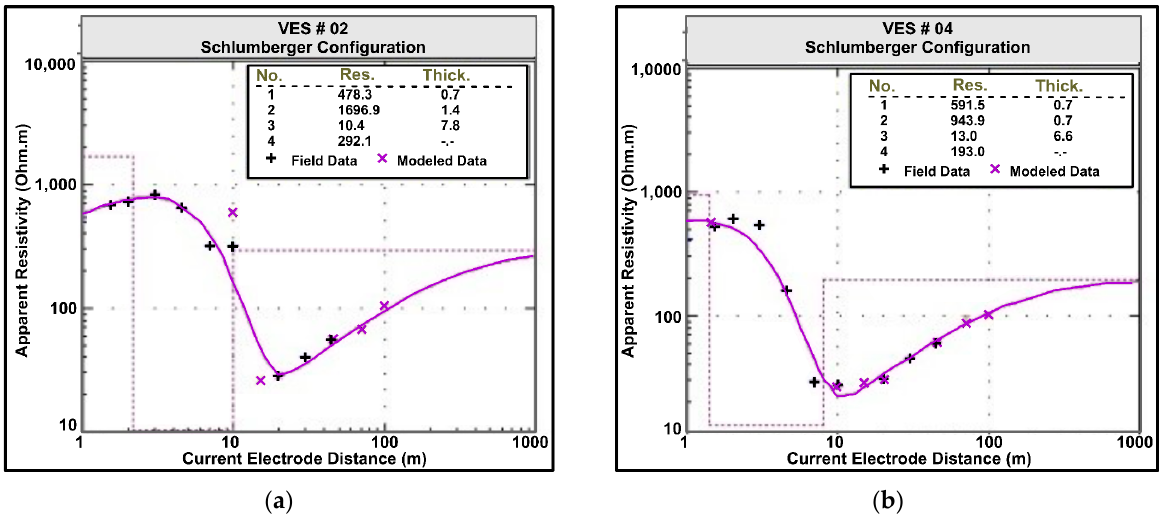
Figure 13. Samples of final interpreted models of the conducted VESs for ( a ) VES-02 and ( b ) VES-04.